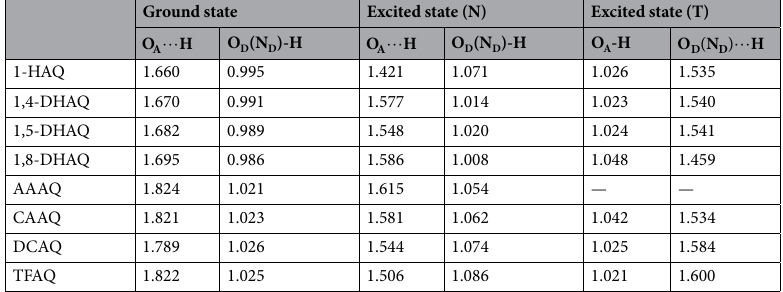
Table 1. Bond length (Å) comparison of ground state and excited state hydrogen bond strength.